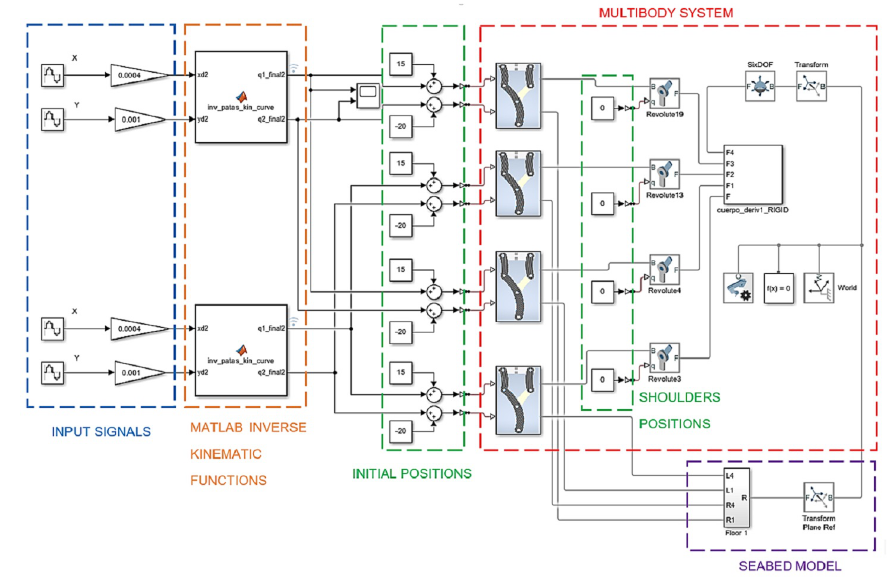
Figure 6. Block diagram for quadrupedal